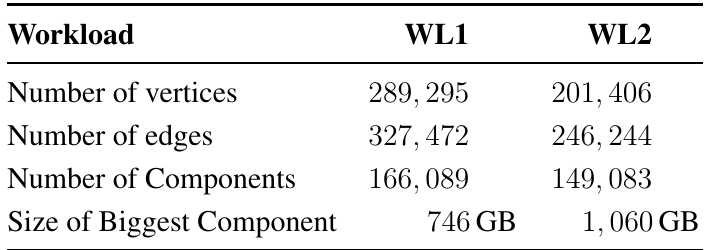
Table 4. Graph Characteristics for workloads WL1 and WL2.